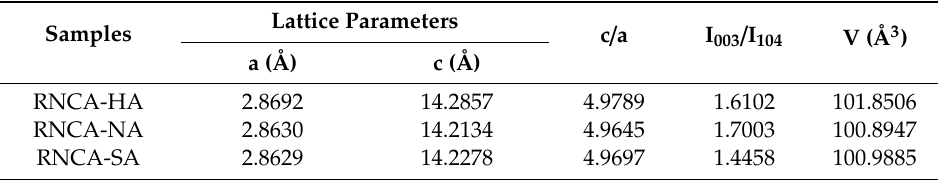
Table 2. Lattice parameters of